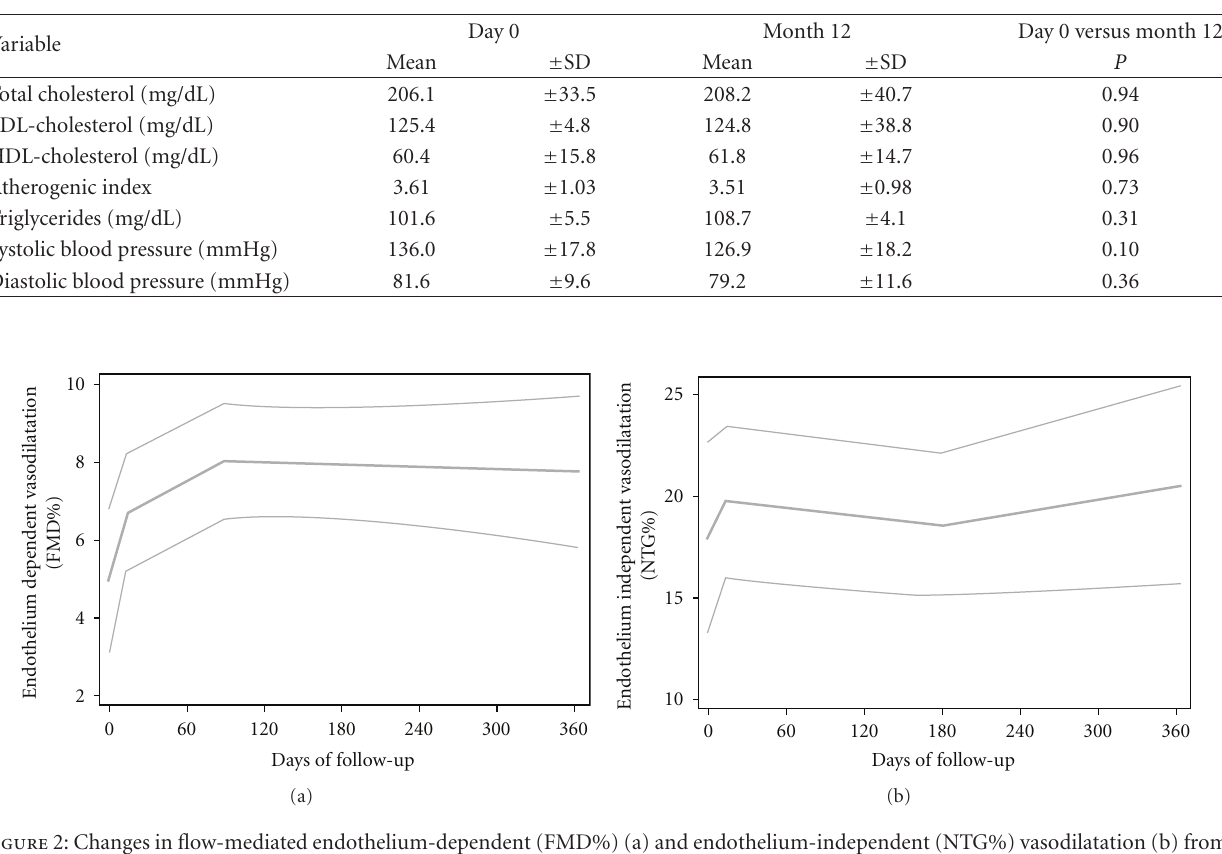
Figure 2: Changes in flow-mediated endothelium-dependent (FMD%) (a) and endothelium-independent (NTG%) vasodilatation (b) from day 0 onwards, obtained via locally weighted regression. Curves are central estimate and lower and upper limits of 95% confidence